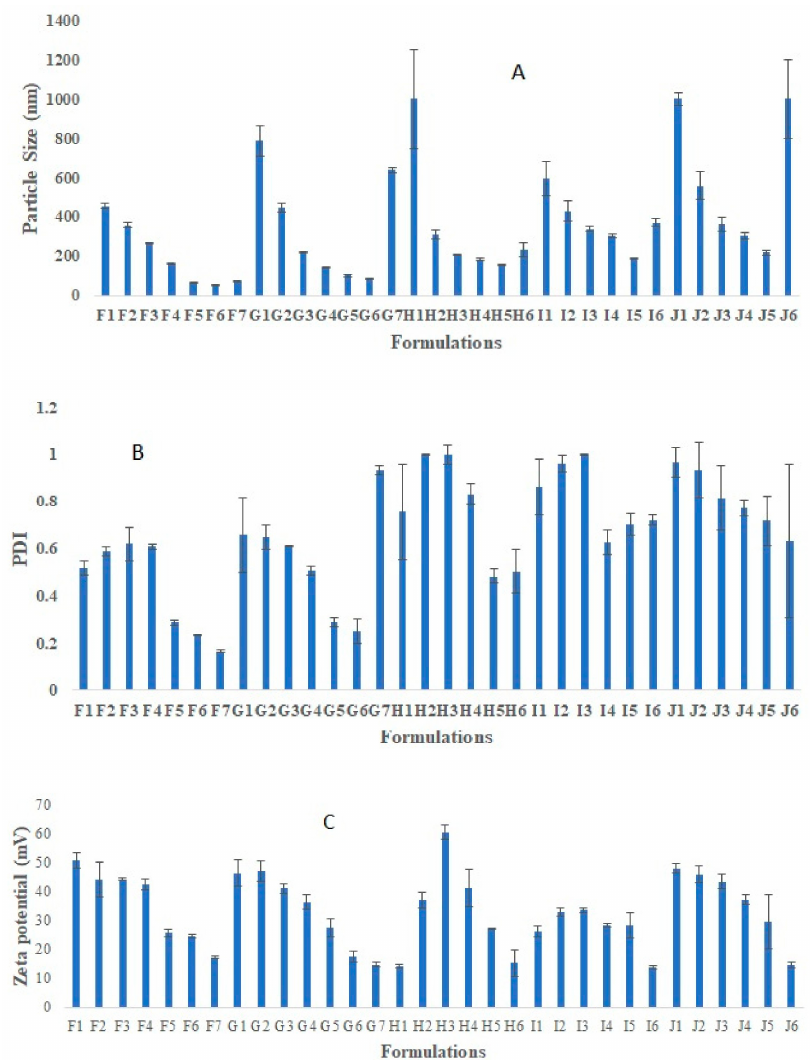
Figure 1. Represent effect of increasing the CS and TPP concentration, TPP volume on Particle size ( A ), PDI ( B ), and zeta potential ( C ). Represent optimization of placebo chitosan (CS) nanoparticles (NPs) using different concentration of CS and TPP (% w / v ), different CS:TPP ratio. There were a total 32 formulations run for optimization purposes. Formulation code F represents 0.05% CS and TPP (% W / V ), G represents 0.1% CS and TPP (% W / V ), H represents 0.15% CS and TPP (% W / V ), I represents 0.175% CS and TPP (% W / V ), and J represents 0.2% CS and TPP (% W / V ). Sub-codings F1, G1, H1, I1, and J1 (1 mL TPP, CS: TPP ratio 10:1), Sub-codings F2, G2, H2, I2, and J2 (2 mL TPP, CS: TPP